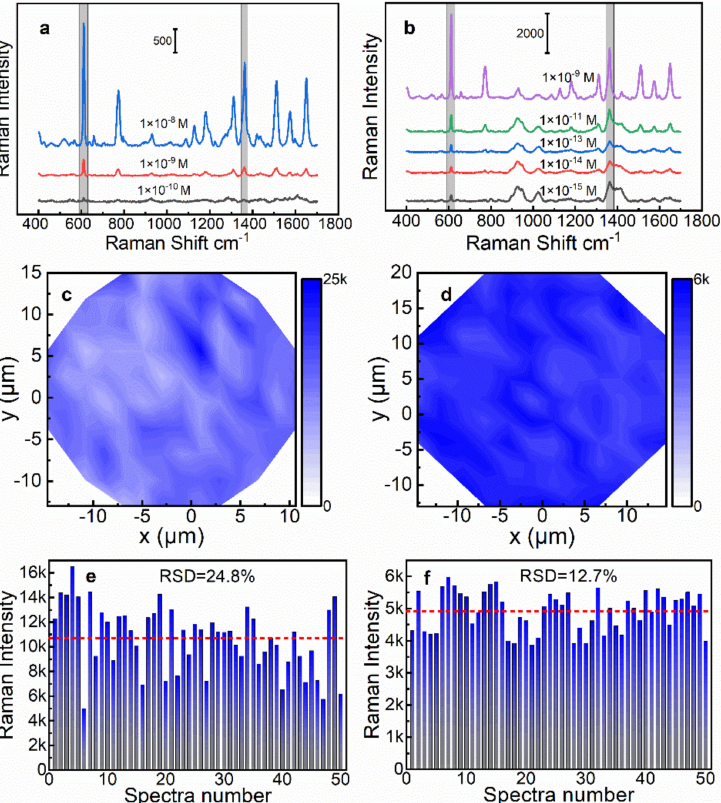
Figure 5. SERS spectra for different concentrations of R6G on ( a ) 4-AgNP@glass SERS substrate and ( b ) 2-AgNP@Au film SERS substrate. SERS mapping results of the 4-AgNP@glass SERS substrate ( c ) and the 2-AgNP@Au film SERS substrate ( d ). Different batch repeatability test results of ( e ) the 4-AgNP@glass SERS substrate and ( f ) the 2-AgNP@Au film SERS